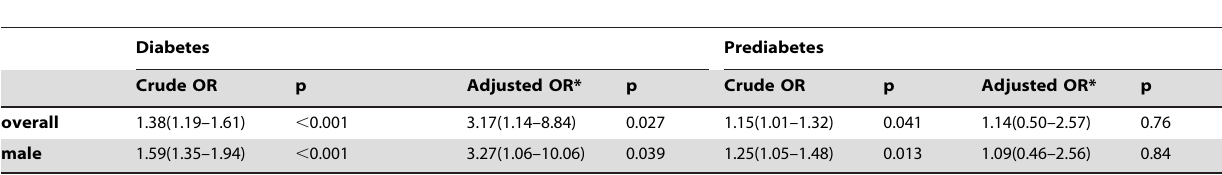
Table 2. Odds Ratio for diabetes and prediabetes by PTB in Linyi, China, 2010–2012.